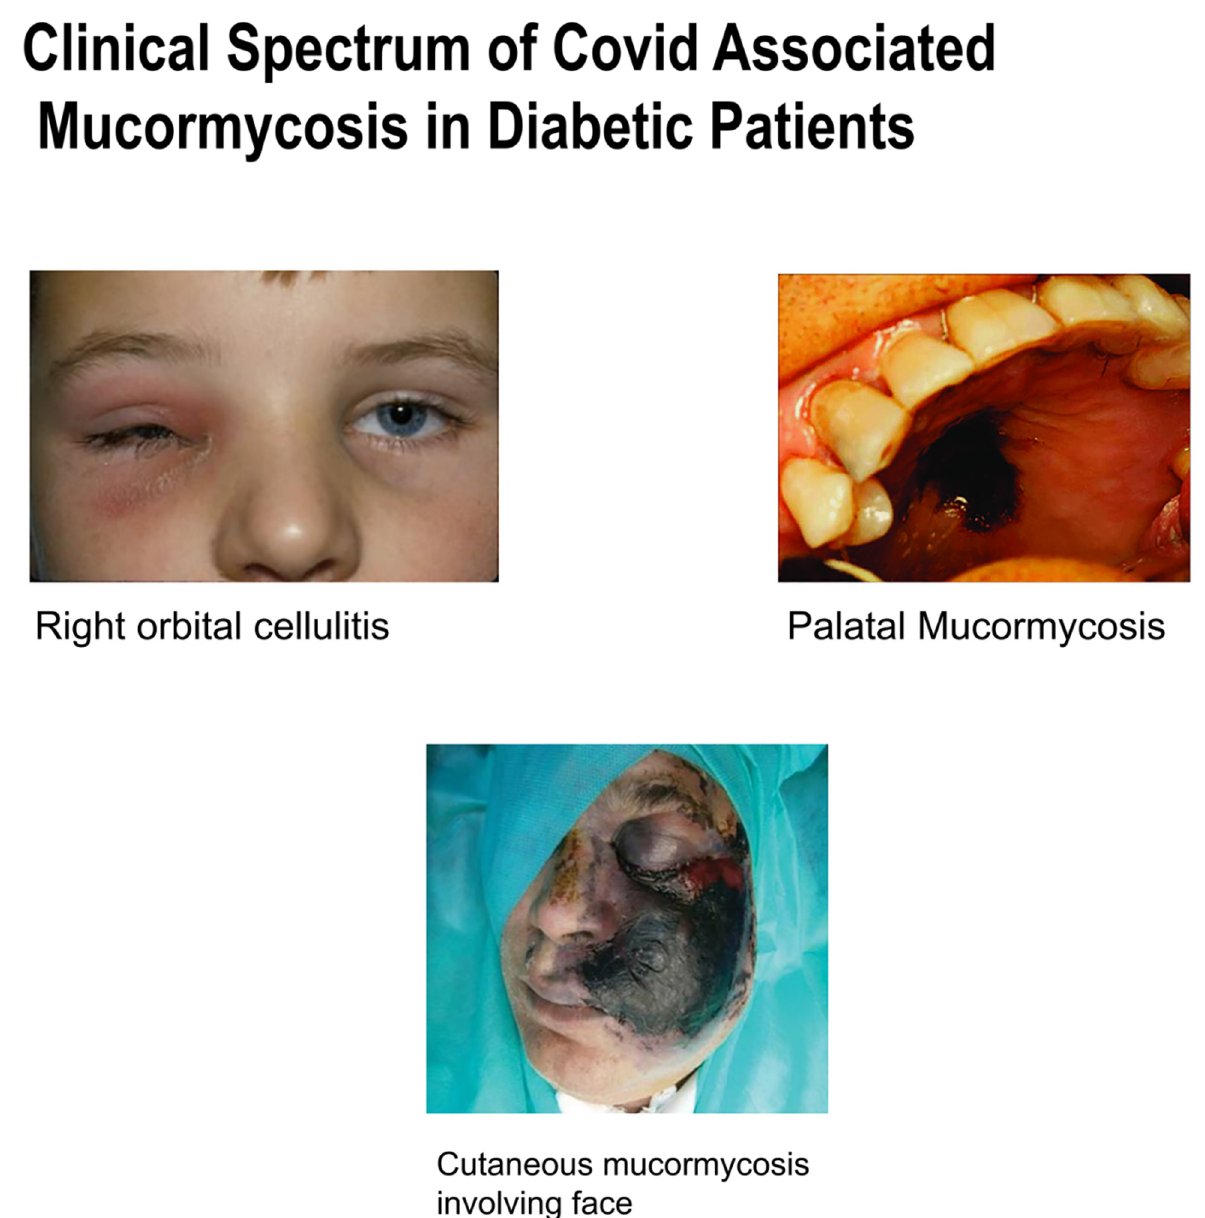
Figure 9. Clinical spectrum of COVID-associated mucormycosis in diabetic